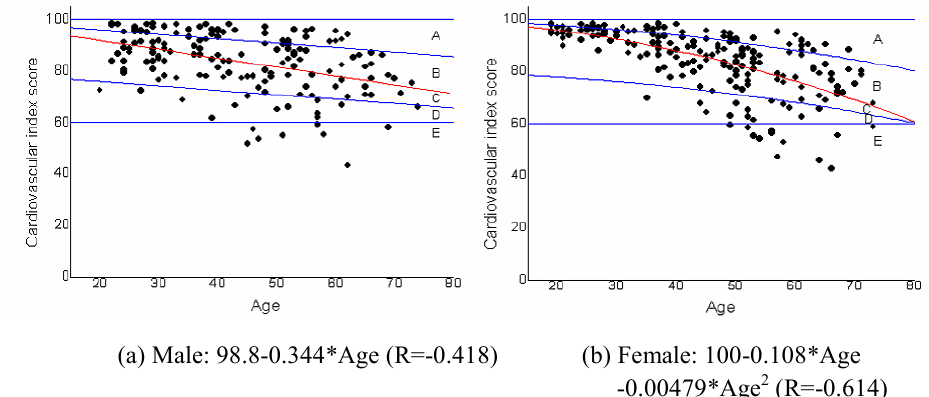
Fig. 3 Regression equation and classification of five regions for cardiovascular index